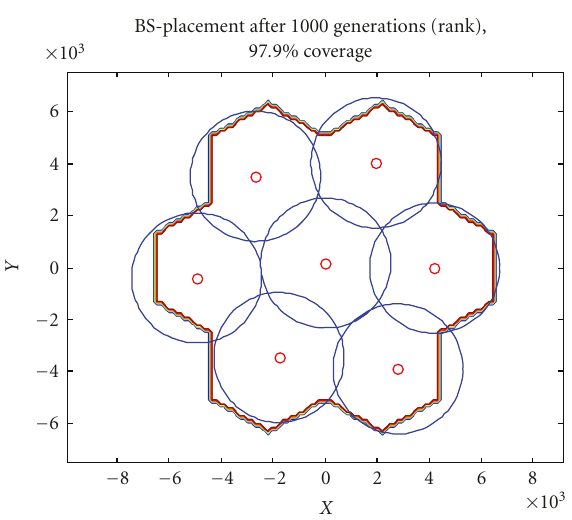
Figure 15: After the 1000th generation, base station location with rank selection.